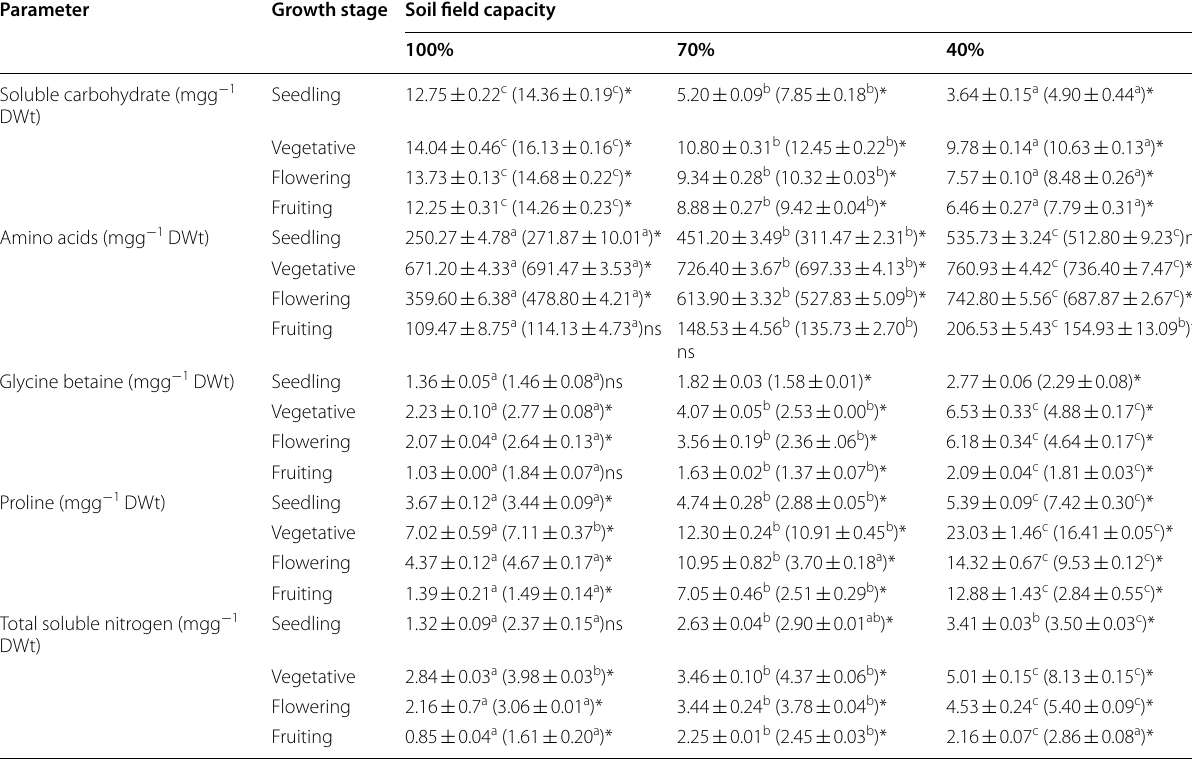
Values of parameters in parentheses correspond to the application of mycorrhiza. Values in a row with different superscript letters are significantly different at P < 0.05 *Significant effect of mycorrhiza application at each soil field capacity at P < 0.05 according to t ‑test ns : non‑significant effect of mycorrhiza application at each soil field capacity at P < 0.05 according to t-